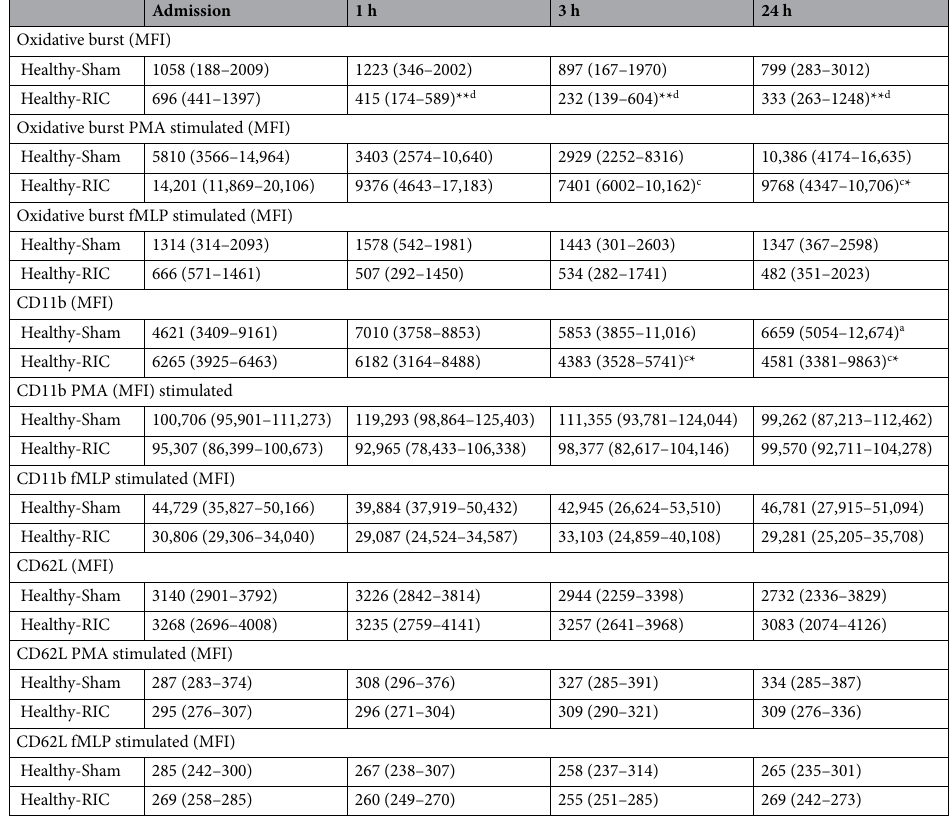
Table 3. Neutrophil oxidative burst and adhesion molecule expression in healthy controls. Values represent median (interquartile range). a P < 0.05 vs Sham Admission. c P < 0.05 vs RIC Admission. d P < 0.01 vs RIC Admission. *P < 0.05 vs Sham. **P < 0.01 vs